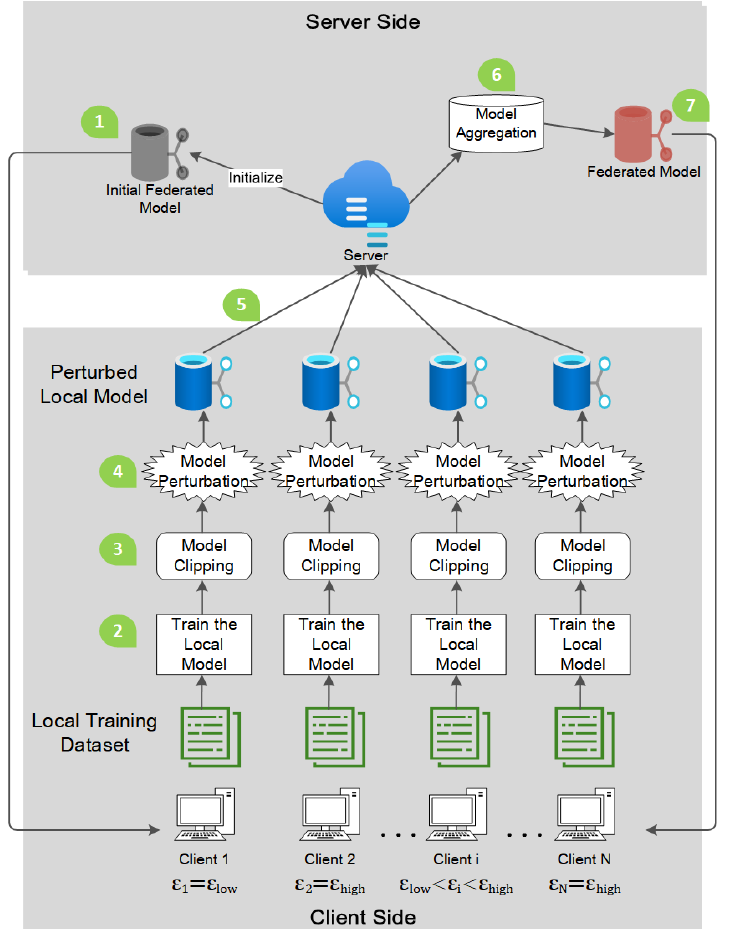
Figure 1. The overall architecture of the federated learning system with personalized local differen- tial